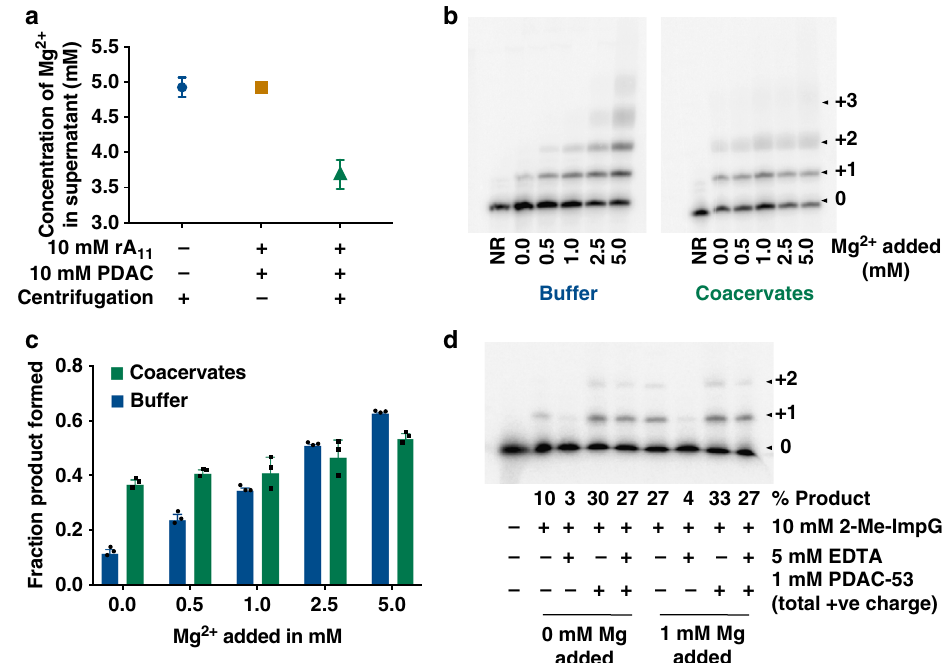
Fig. 3 Template-directed polymerization at sub-optimal Mg concentrations. a Mg 2 + levels were measured by atomic absorption spectroscopy. Solutions with 5 mM MgCl 2 were formed in 25 mM Tris – HCl pH 8.0 with indicated anions and cations, followed by centrifugation at 14,000× g for 2 min. A portion of the supernatant phase was removed and diluted in water prior to measurement. Error bars represent the range of values from two experiments. b Yields of template-directed polymerization at different amounts of added Mg in presence and absence of PDAC-53/rA 11 coacervates. c Quanti fi cations from b . Error bars represent S.E.M. from three independent experiments. d Template-directed polymerization reactions were assembled as previously described in the presence or absence of indicated molecules and ions. Uncropped gel images are shown in Supplementary Figure 15a,